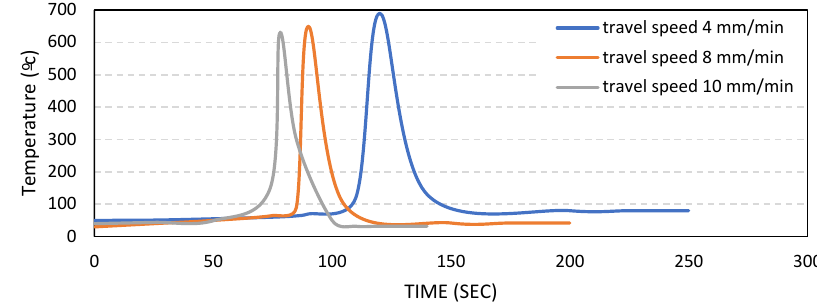
Figure 14. Temperature measurements at 7 mm away from the weld line along the lateral axis of the specimen for different travel speeds (RS: 1400 rpm; AF: 2kN).